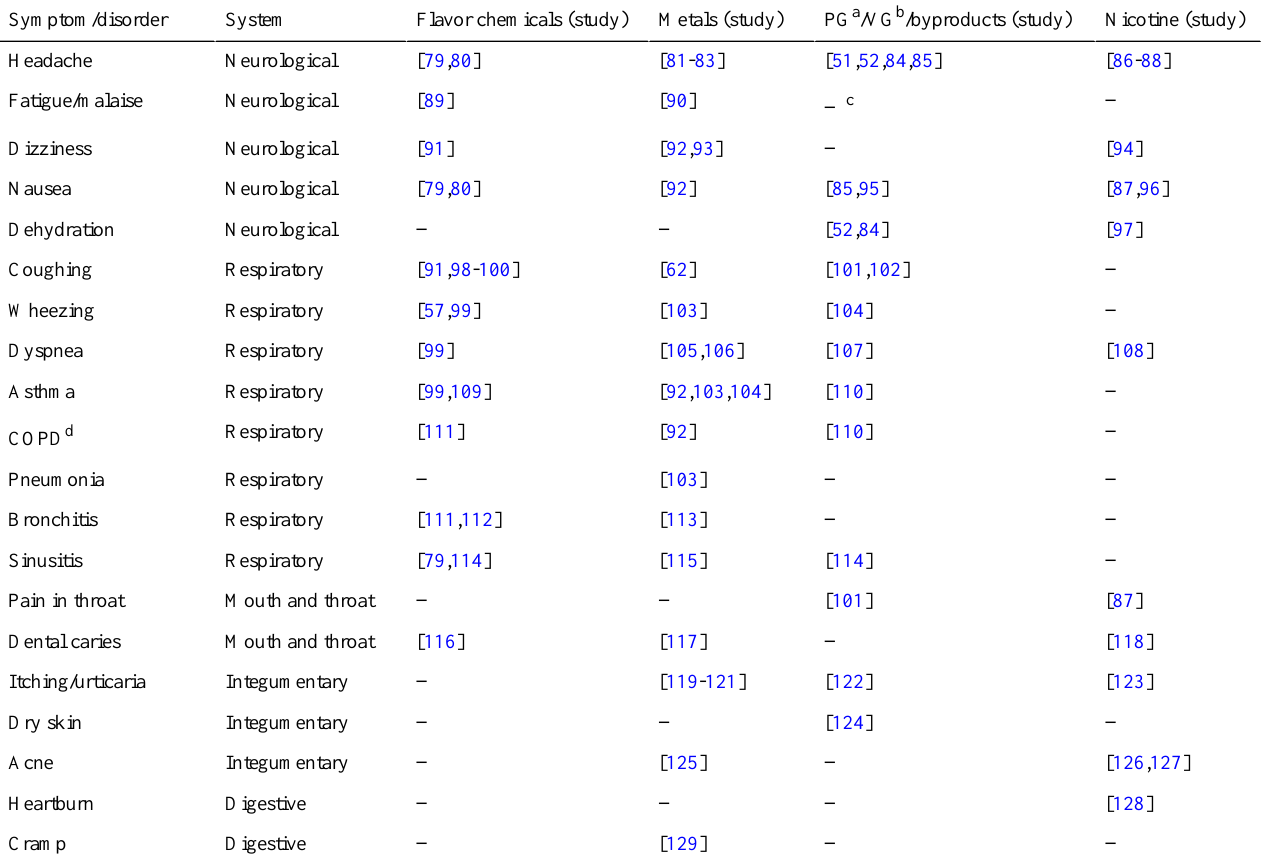
Table 4. Examples of chemical components in electronic cigarettes that may cause major symptoms/disorders with reference citations of